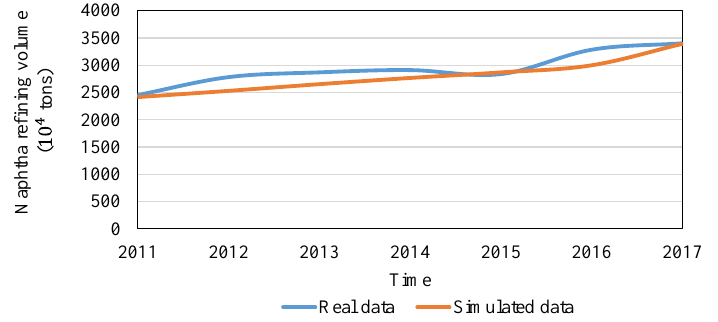
Figure 12. Compare the volume of naphtha refining with real data and simulated